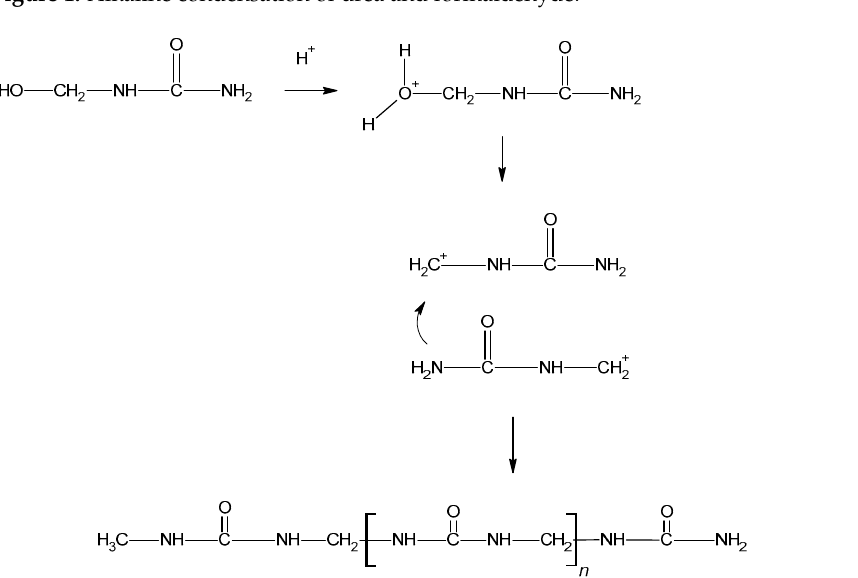
Figure 1. Alkaline condensation of urea and formaldehyde.